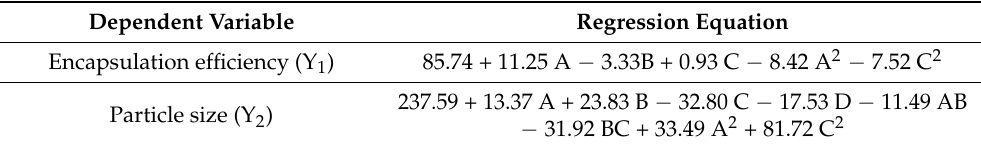
Table 4. Polynomial equation for the responses—encapsulation efficiency and particle size.